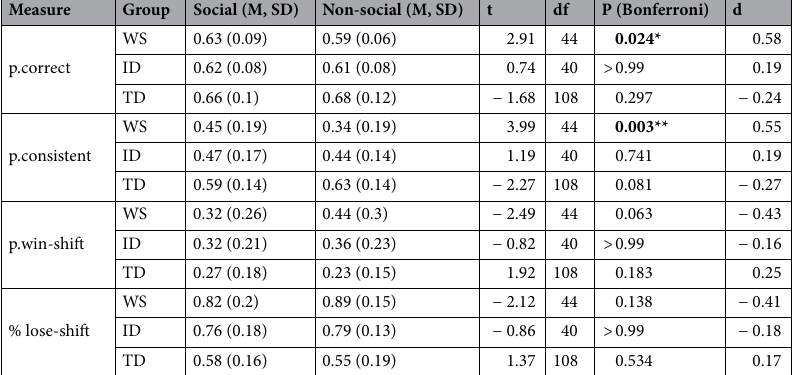
Table 3. Within-groups comparisons for choice behavior measures. Significant values are in bold. WS Williams syndrome, ID intellectual disability, TD typically developed adults. p-values are corrected for multiple comparisons for each variable using the Bonferroni method. *p < 0.05, **p < 0.01, *** p < 0.001.